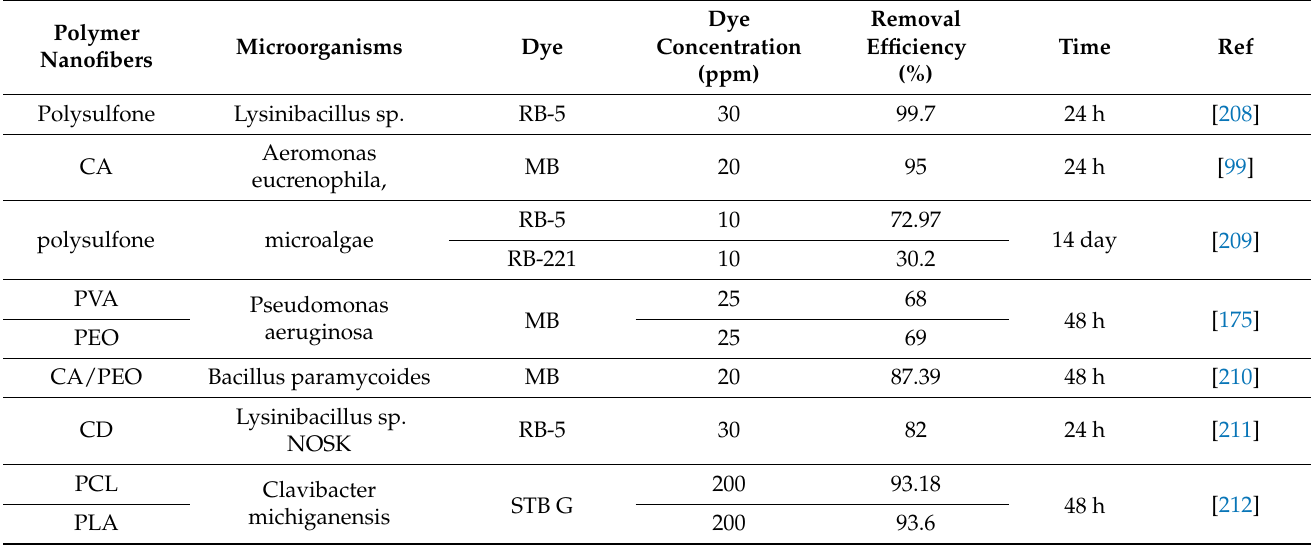
Table 8. Removal of dyes by EPNFs/bacteria